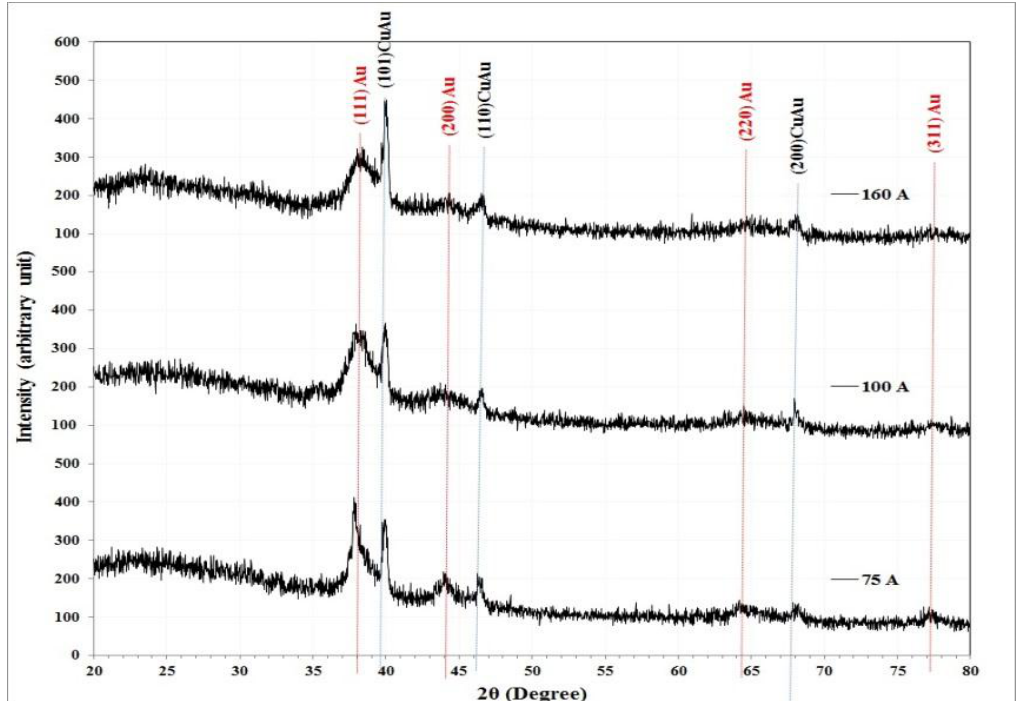
Fig. 2: X-ray diffraction pattern of A-alloy nanoparticles prepared by exploding of wire for a different current (75 A, 100 A, 160 A).